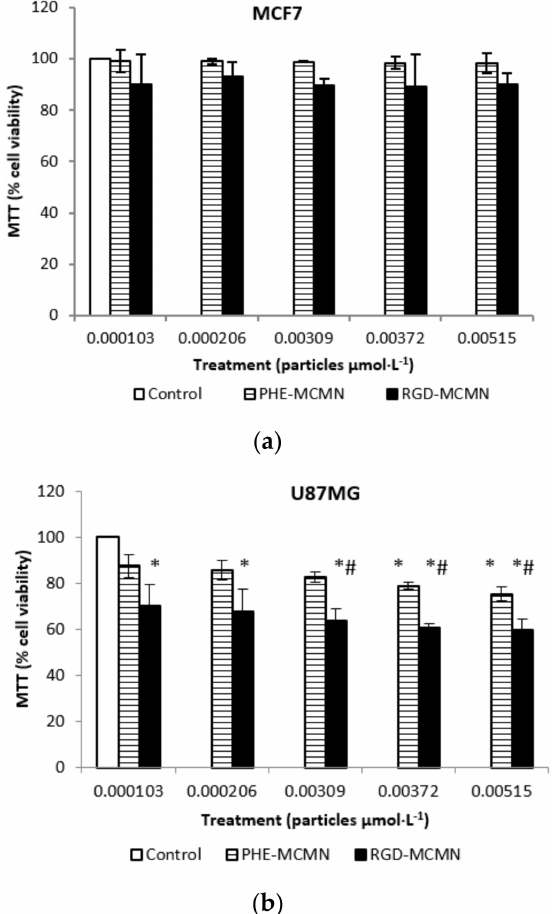
Figure 4. ( a ) Effect of Phe-MCMN and RGD-MCMN on the cell viability of human breast cancer cells (MCF-7 cell line) and ( b ) glioblastoma cells (U87MG cell line) using MTT assay. Cells were treated for 24 h with different nanocapsule concentrations (1.03 × 10 − 4 , 2.06 × 10 − 4 , 3.09 × 10 − 3 , 3.72 × 10 − 3 and 5.15 × 10 − 3 µ mol of particles per liter of well). Control group did not receive any treatment (100% cell viability). Notes: data are expressed as mean ± standard error. * Indicates significant differences compared to the control; # indicates significant differences compared to the respective concentrations; * # indicates significant differences between cell lines. Differences were considered significant at p <